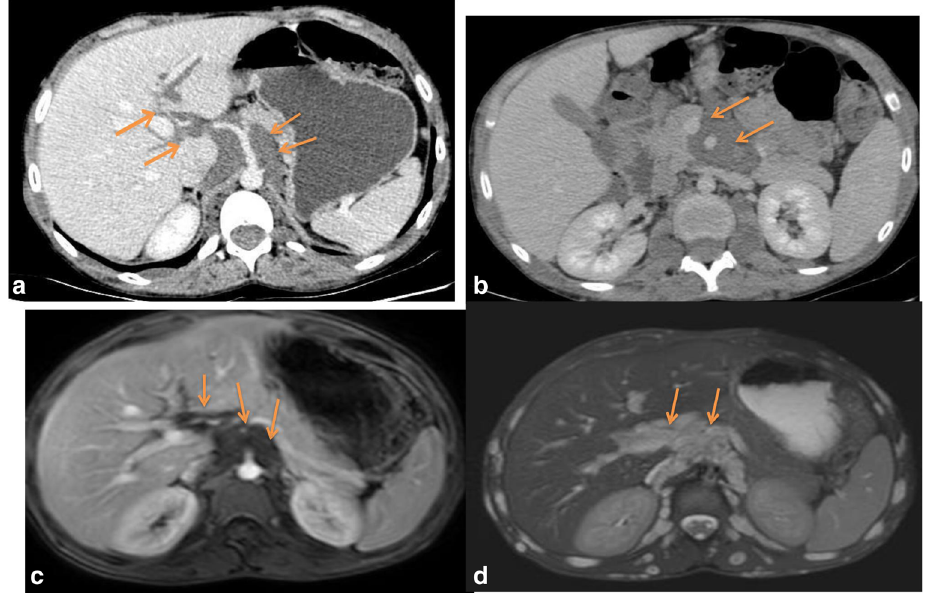
Fig. 4 A 13-year-old boy with systemic NF1. Small bowel CT scan ( a , b ) and MRI ( c , d ) show a lobulated mass surrounding the retroperitoneal vessels extending from the left lateral aortic region to hepatic hilum